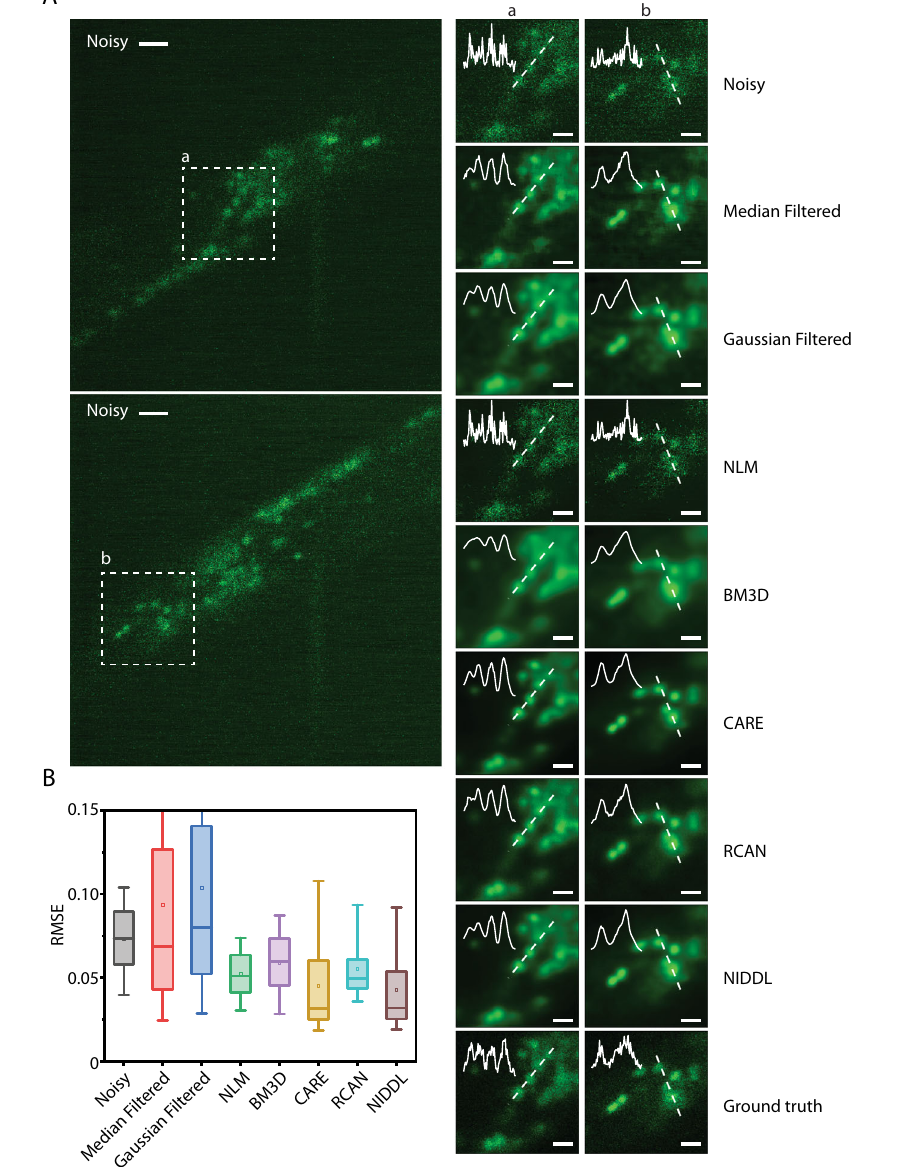
Fig. 2 | NIDDL denoises whole-brain images in C. elegans . A (Left) Two example noisyimages(single z planes)fromnoisywhole-brainimagestacks(acquiredatlow laserpower)(scalebar − 10 μ m).(Right)correspondingdenoisedoutputgenerated by different methods shown for the dotted box in noisy images (scale bar − 5 μ m). Cell nuclei are labeled with nuclear localized GCaMP5K. Data come from strain ZIM504.Insetshowsintensitypro fi lealongthedottedline. B Comparisonof RMSE